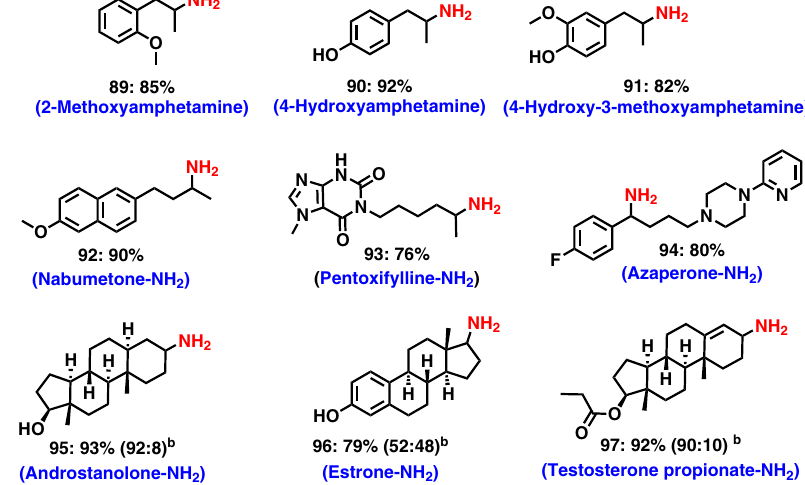
Fig. 4 Synthesis of drugs and amination of complex molecules. a Reaction conditions: 0.5 mmol ketone, 3 mol% RuCl 2 (PPh 3 ) 3 , 5 – 7 bar NH 3 , 40 bar H 2 1.5 mL t-amyl alcohol, 130 o C, 24 h, isolated yields. Isolated as free amines and converted to hydrochloride salts. Corresponding hydrochloride salts were subjected to NMR analysis. b Diastereomeric ratio